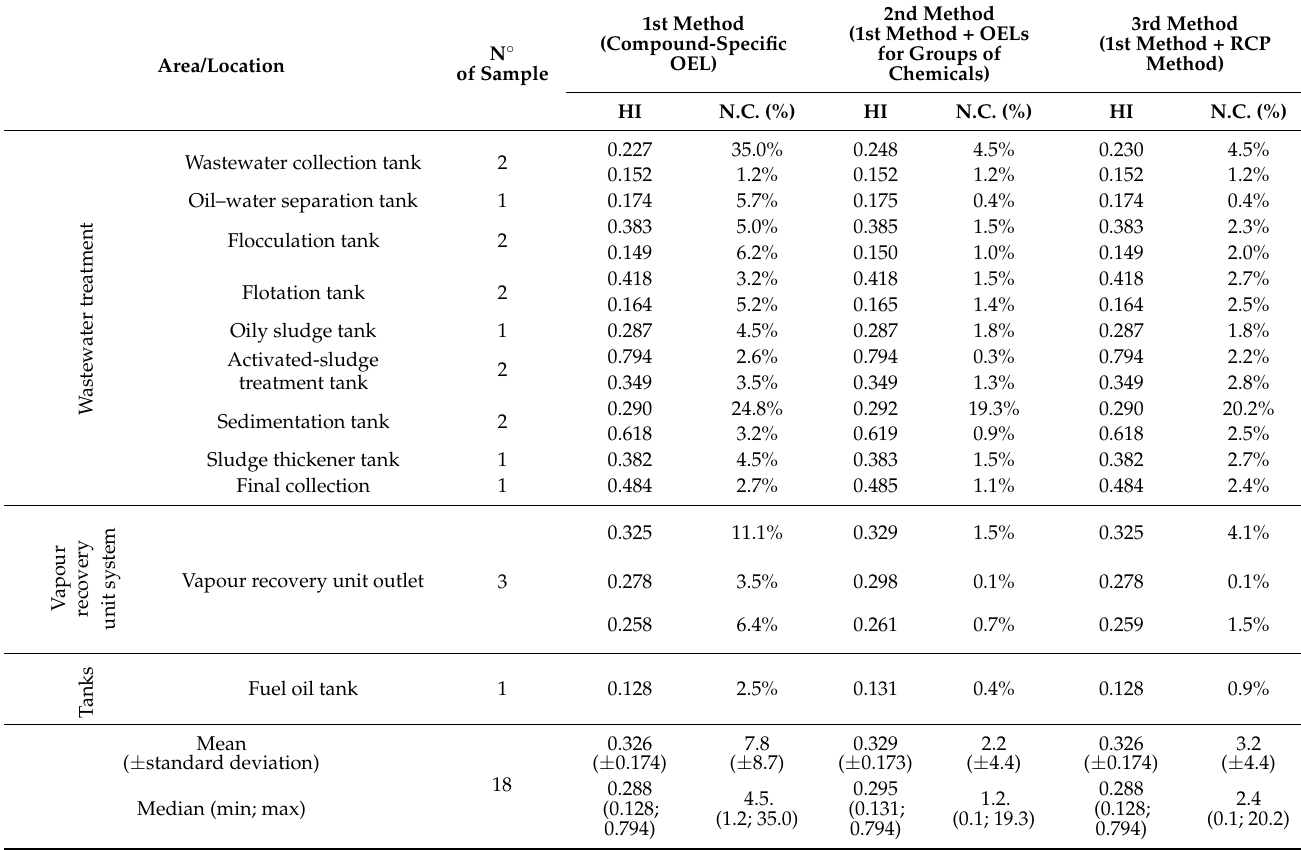
Table 3. Non-carcinogenic risk evaluated applying different approaches: HI = hazard index, calcu- lated with different methods: 1st method (compound-specific OEL); 2nd method (1st method + OELs for groups of chemicals); 3rd method (1st method + RCP). N.C. (%) = percentage of the detected chemical compounds for which it was not possible to calculate a HQ